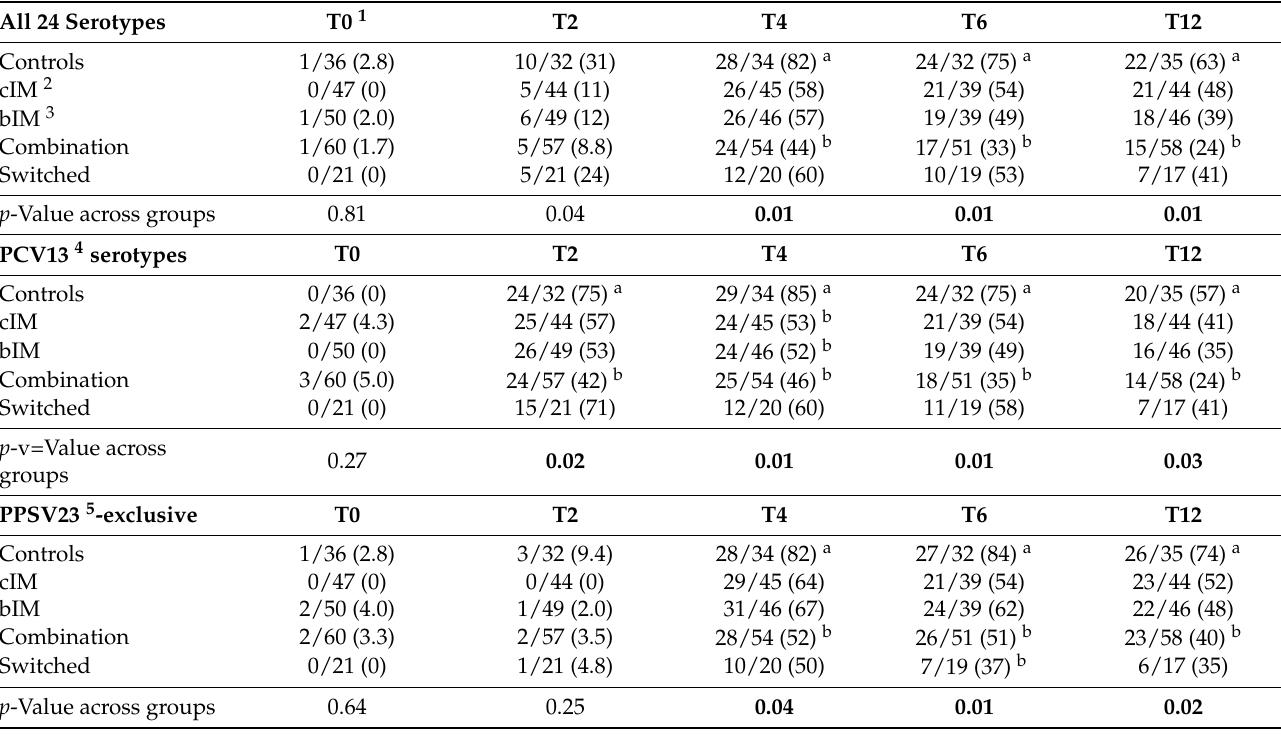
Table 2. Seroprotection rates.